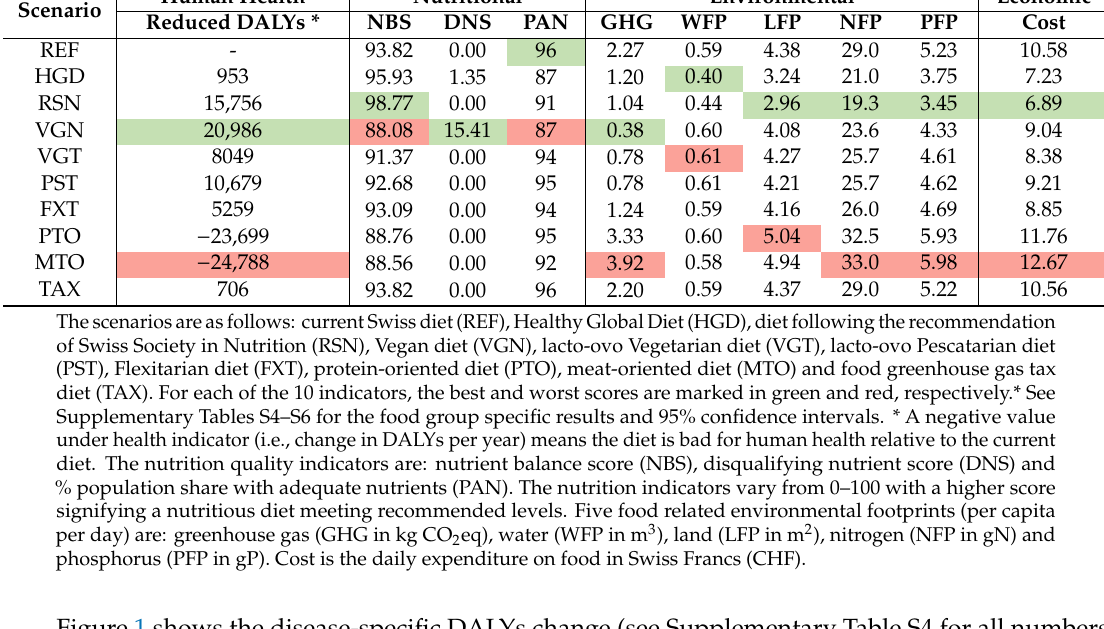
Table 2. Human health, nutritional, environmental and economic indicator scores under di ff erent Swiss dietary scenarios.